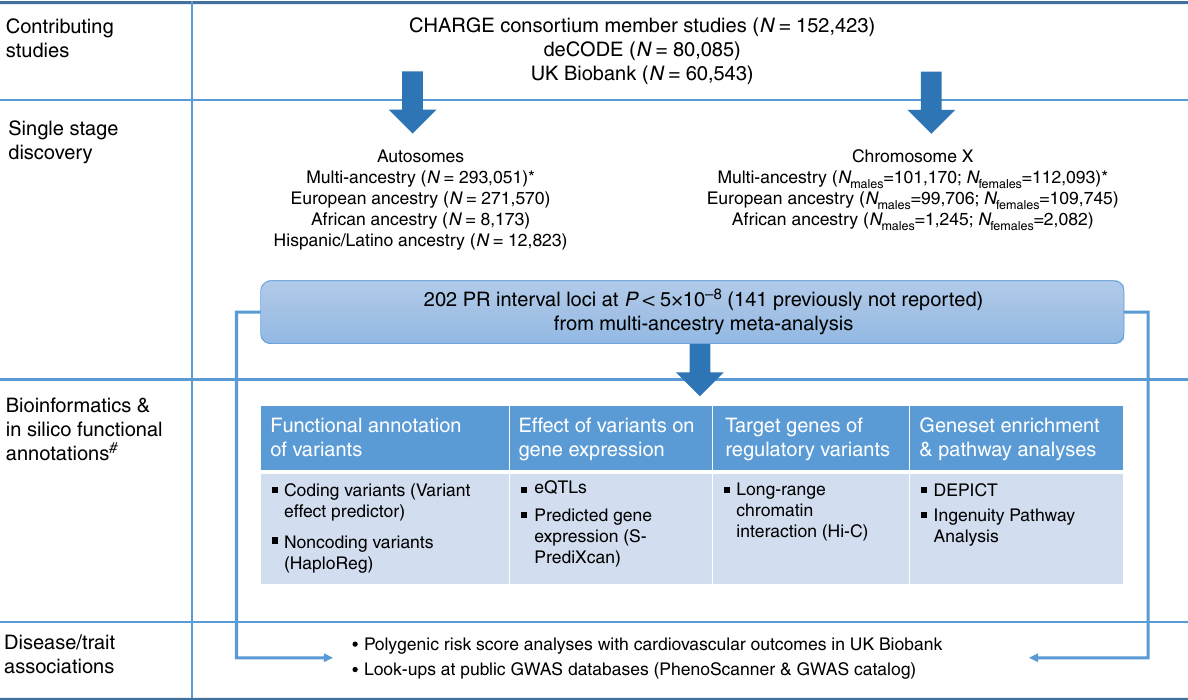
Fig. 1 Overview of the study design. An overview of contributing studies, single-stage discovery approach, and downstream bioinformatics and in silico annotations performed to link variants to genes, and polygenic risk score analysis to link variants to cardiovascular disease risk is illustrated. Asterisk (*) The multi-ancestry meta-analysis is our primary analysis. Previously not reported loci were identi fi ed from the multi-ancestry meta-analysis. Ancestry speci fi c and chromosome X meta-analysis are secondary. Hash ( # ) For bioinformatics and in silico annotations we also included loci that reached genome-wide signi fi cance in European only meta-analysis ( N = 8) and were borderline genome-wide signi fi cant in the multi-ancestry meta-analysis.